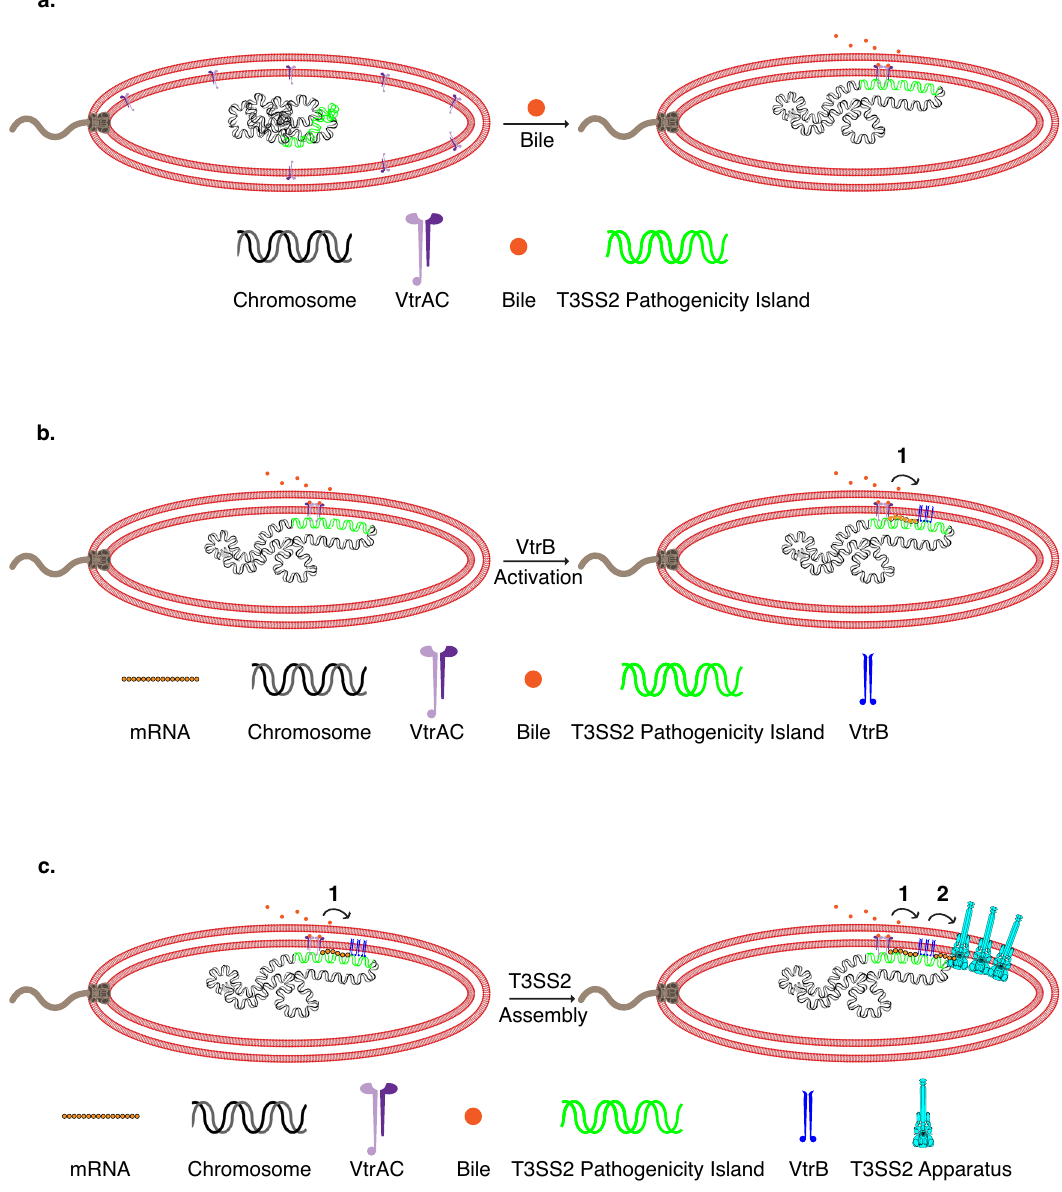
Fig.1|Two-steptransertionmodelforthelocalizedmembraneassemblyofthe T3SS2 apparatus in V. parahaemolyticus. Illustrations depicting a dimerization and activation of VtrA/VtrC upon binding bile acid, which captures the T3SS2 pathogenicity island containing the vtrB genomic locus at the inner membrane, b fi rst transertion step, starting with transcription initiation of vtrB by VtrA/VtrC, and concurrent translation and membrane insertion of the VtrB protein in the